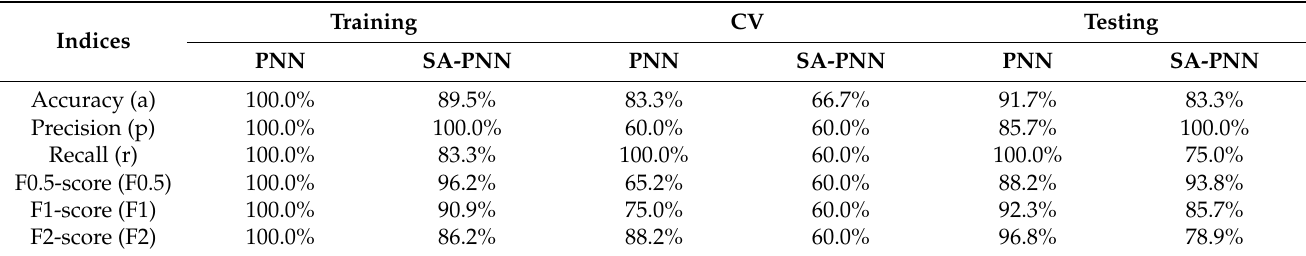
Table 10. Model performance comparison between established PNN model and SA-based PNN (SA-PNN)